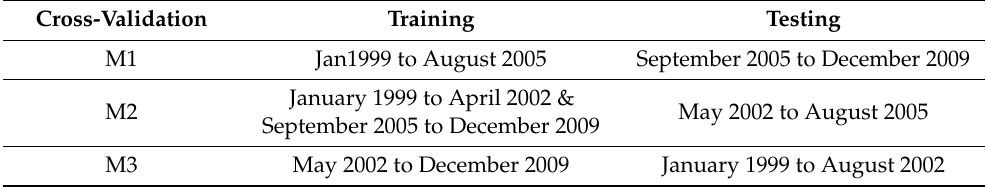
Table 3. The training and test data sets used in the study (Kisi and Parmar,